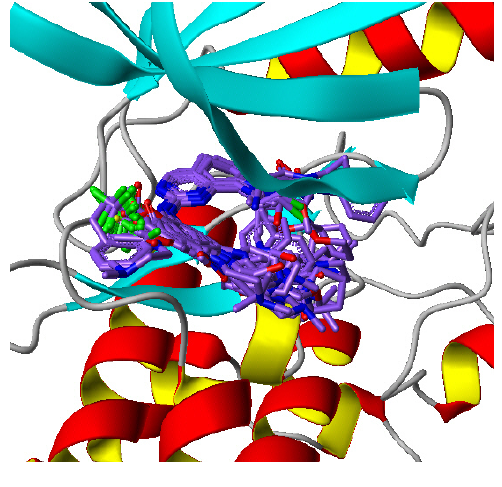
Figure 3. The resultant conformations from GLIDE